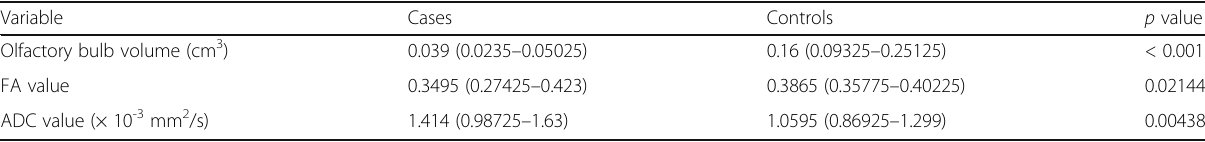
Data are medians (interquartile range). Wilcoxon rank sum